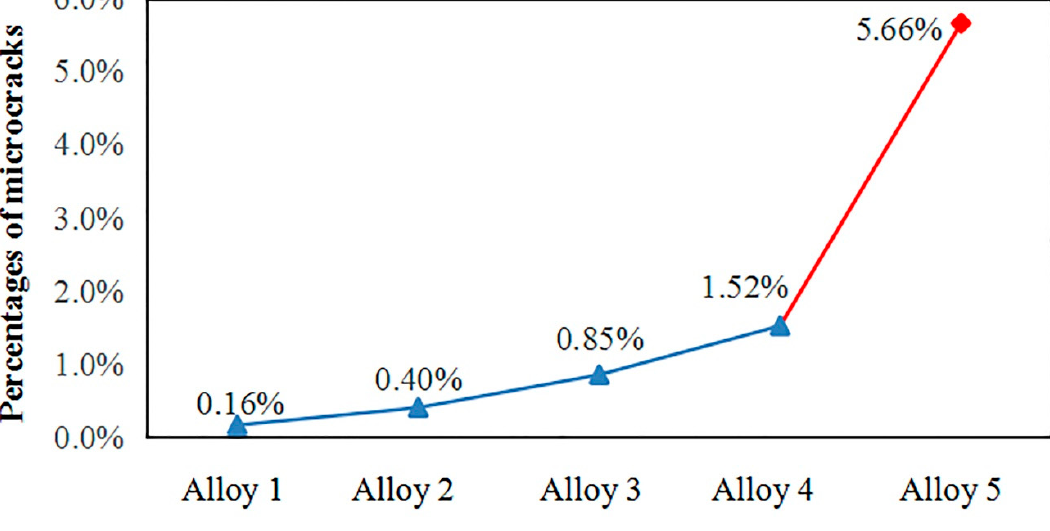
Figure 9. Percentages of micro-cracks in the welds.